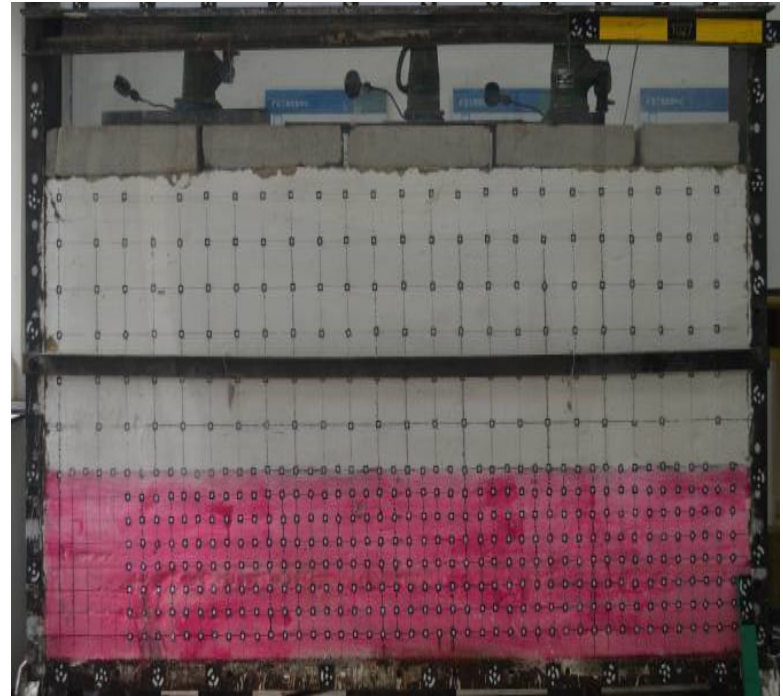
Figure 2. Experiment model of the two-dimensional plane stress.